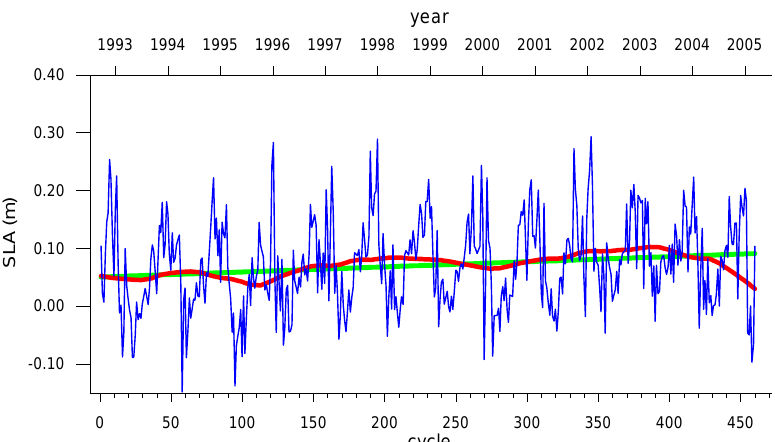
Figure 3c. Various curves for DataSet1 in the Sub-Arctic region. blue : SLA; red : interannual variations; green : linear